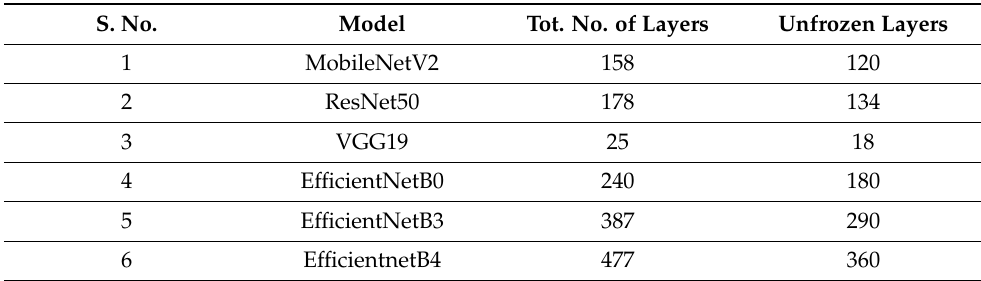
Table 1. Fine-tuning of deep CNN models. S. No. Model Tot. No. of Layers Unfrozen Layers 1 MobileNetV2 158